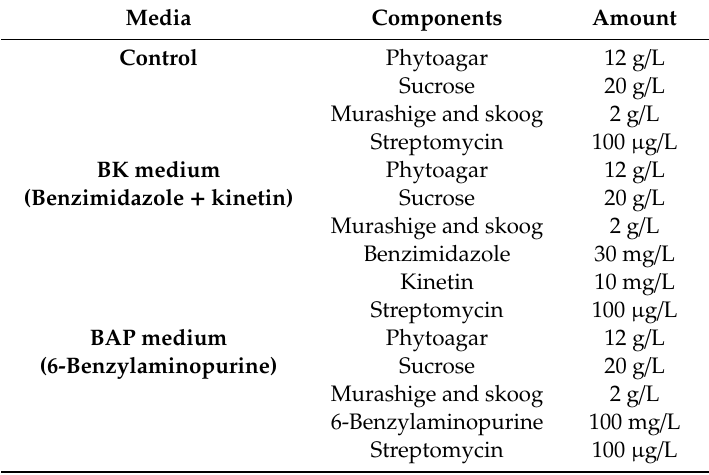
Table 1. Compositions of the defined